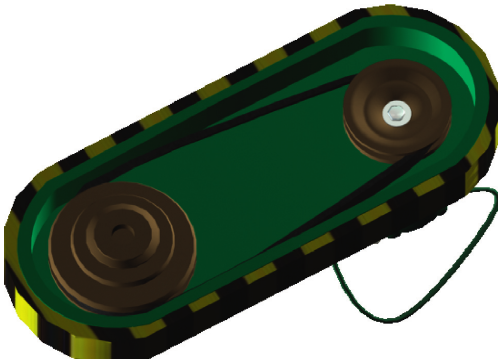
Figure 1: Use of a compound object Boolean from modeling of pulley safety guard of Drill Press.